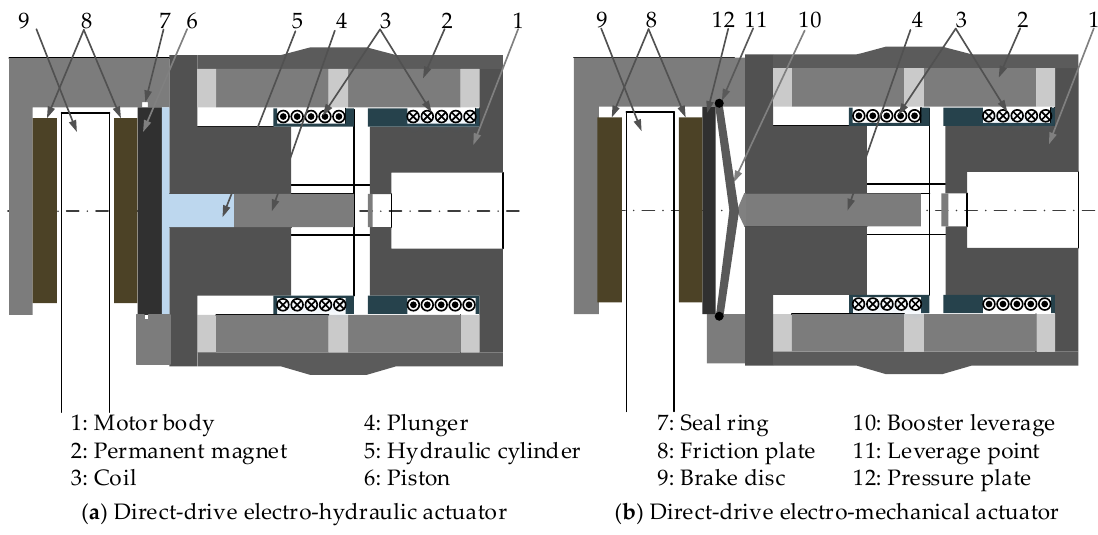
Figure 8. Direct-drive electro-hydraulic /electro-mechanical actuator.